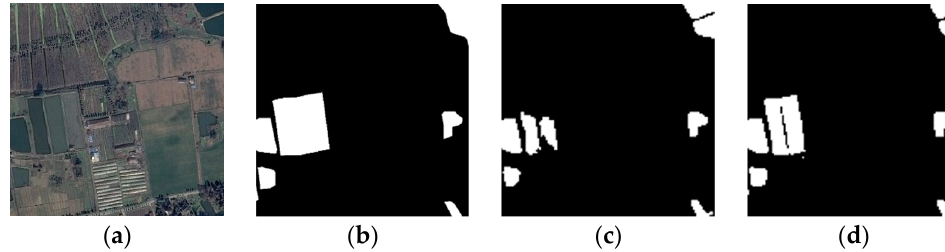
Figure 8. Results of ablation experiment. ( a ) Image. ( b ) Ground truth. ( c ) HRnet V2 + SSA. ( d ) HRnet V2 + SSA + MFF. Table 3. Evaluation of water body extraction results obtained by different models.